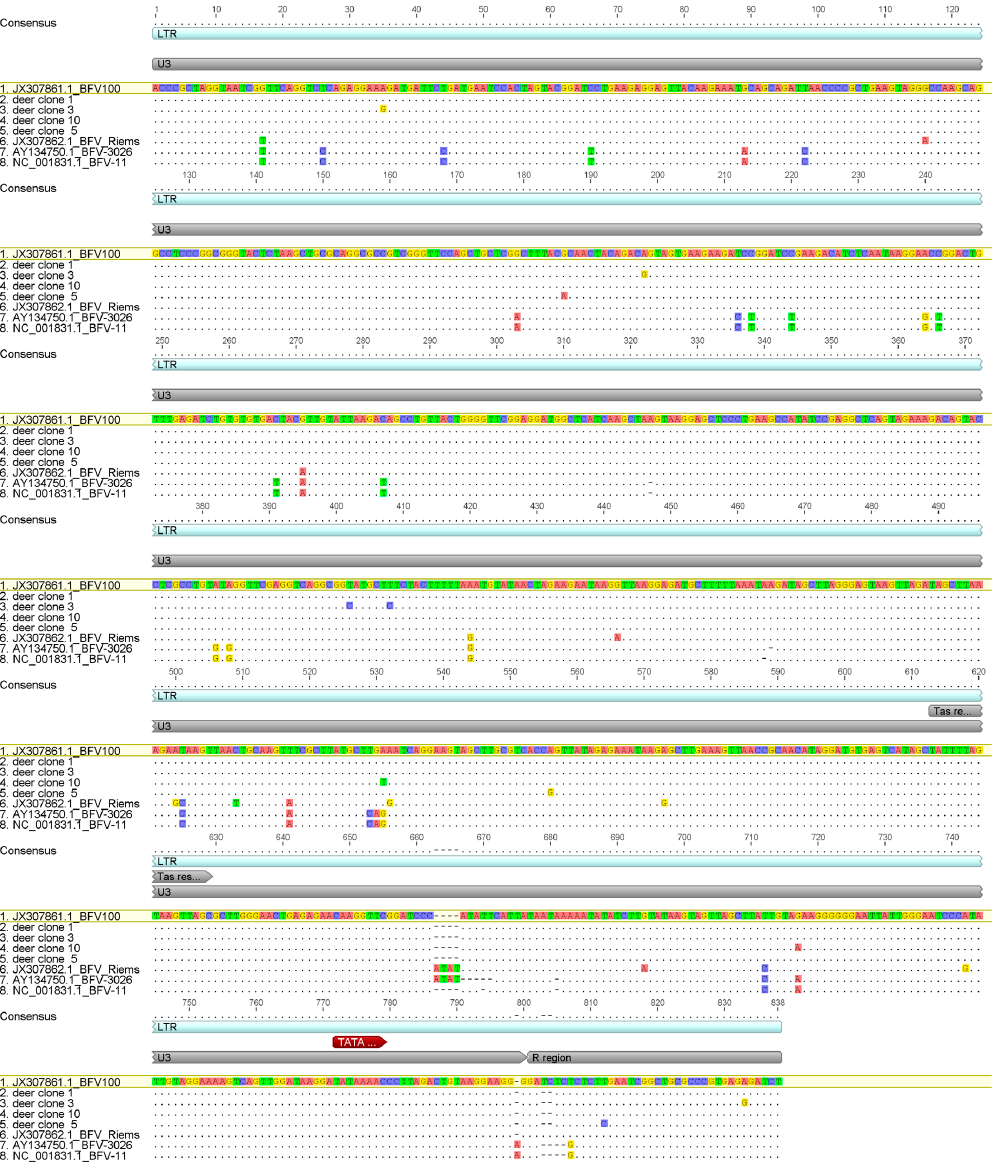
Figure 6. Alignment of the LTR clones sequences derived from red deer no. 113 / 13 with respective sequences extracted from BFV isolates available in GenBank.